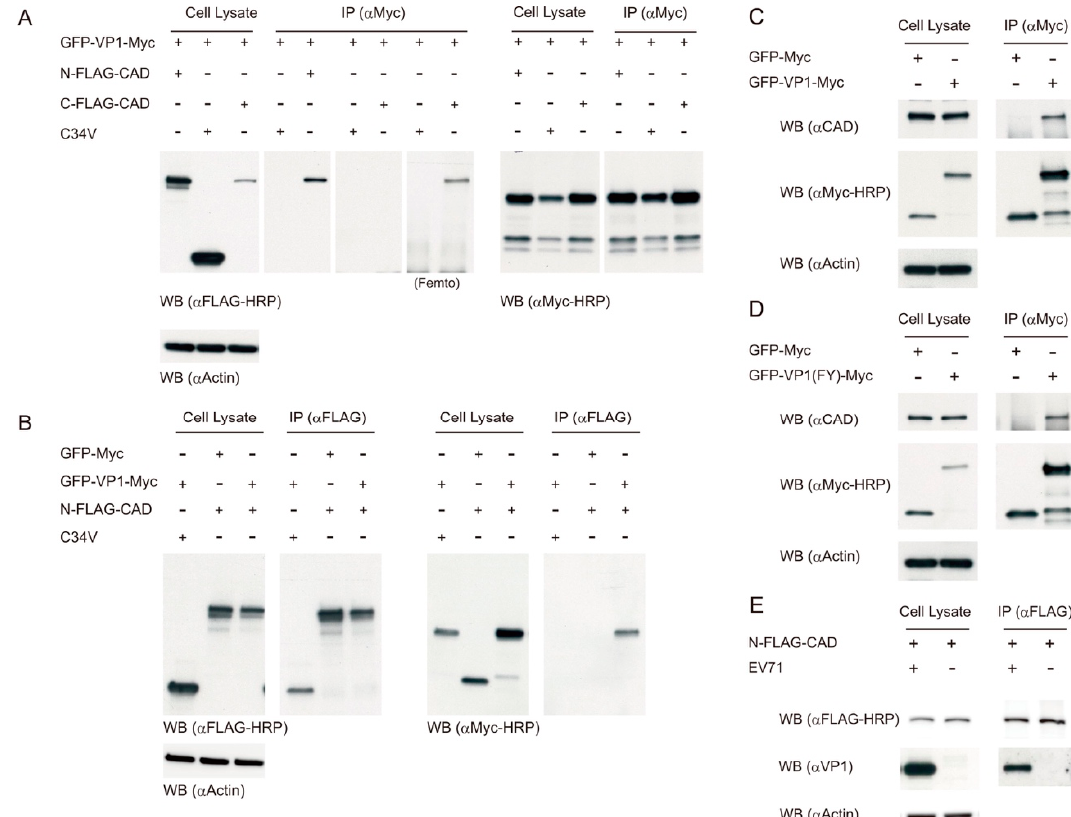
Figure 8. Interaction between VP1 and CAD. ( A ) Vero cells were transfected with the plasmid encoding GFP-VP1-Myc and that coding for N-FLAG-CAD, C-FLAG-CAD, or C34V. Forty-eight hours later, the cell lysate was prepared for immunoprecipitation with anti-c-Myc antibody ( α Myc; c-Myc monoclonal antibody 9E10), and the subsequent western blotting with HRP-conjugated anti-FLAG antibody ( α FLAG-HRP; MA1-91878) for detection of the co-immunoprecipitated N- or C-FLAG-CAD, or with HRP-conjugated anti-c-Myc antibody ( α Myc-HRP; R951-25) for detection of GFP-VP1-Myc. ( B ) Reciprocal immunoprecipitation with anti-FLAG antibody ( α FLAG; FLAG M2 monoclonal antibody) was followed by western blotting with α Myc-HRP for detection of the co-immunoprecipitated GFP-VP1-Myc, or with α FLAG for detection of N-FLAG-CAD. The cell lysate was immunoblotted with α FLAG-HRP, α Myc-HRP or anti-actin ( α Actin) antibodies. A representative result of three experiments is shown. ( C , D ) Vero cells were transfected with expression vector of GFP-VP1-Myc ( C ), GFP-VP1(FY)-Myc ( D ) or GFP-Myc (negative control) for 48 h, and the cell lysate was subjected to immunoprecipitation with α Myc and western blotting with anti-CAD antibody ( α CAD) or with α Myc-HRP. The cell lysate was immunoblotted with α CAD, α Myc-HRP and α Actin. A representative result of three experiments is shown. ( E ) Vero cells were transfected with the plasmid encoding N-FLAG-CAD for 48 h, and the transfected cells were infected with EV71 at MOI of 1.25 for 24 h. The cell lysate was subjected to immunoprecipitation with α FLAG and western blotting with anti-VP1 antibody ( α VP1) and α FLAG. The cell lysate was immunoblotted with α VP1, α FLAG-HRP and α Actin. A representative result of three experiments is